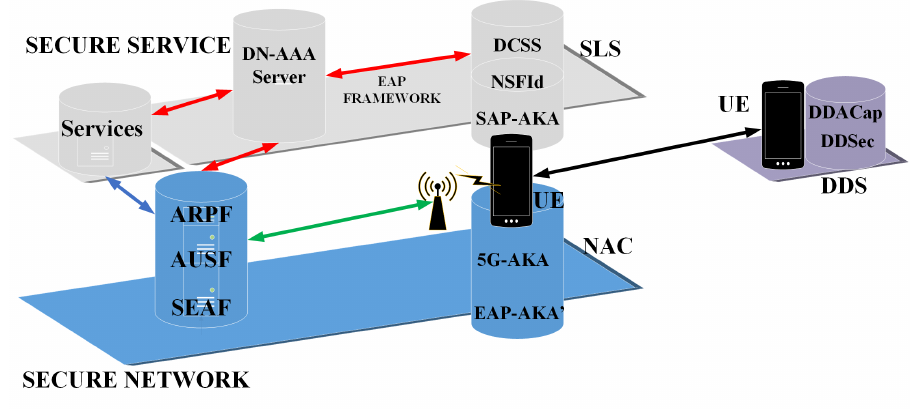
Figure 3. Security